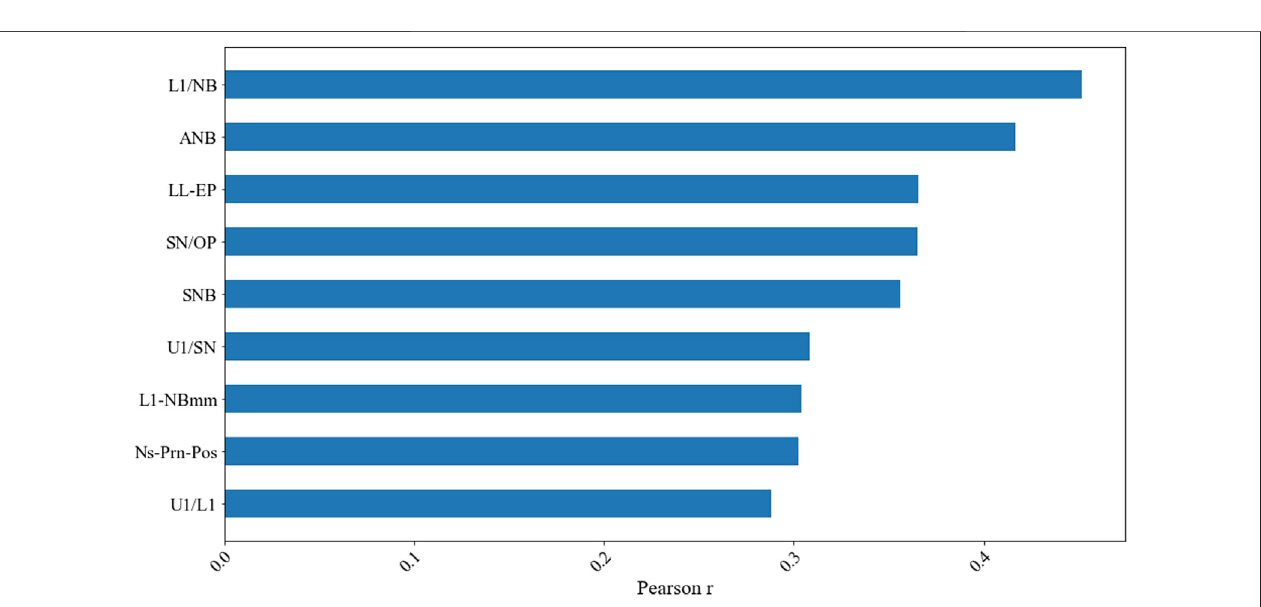
FIGURE 9 | Results of the Pearson correlation coef fi cient from the testing set when nine factors were included by using the XGBoost regression model.